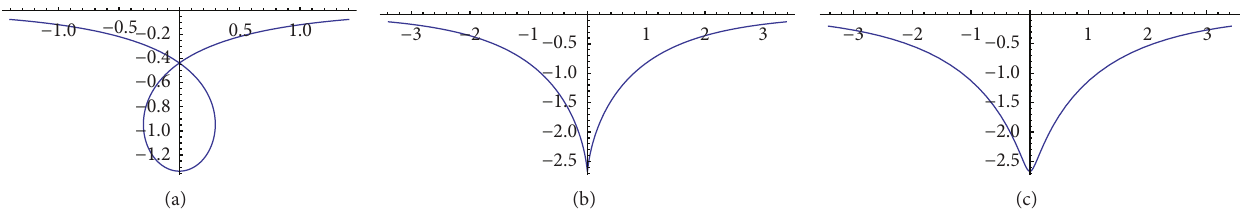
Figure 1: The profile of solution (44) with 𝑝 = 3 , 𝑞 = 1.5 , 𝑡 = 0 , and 𝑥 0 = 0 . For (a) loop-shaped 𝛽 = 0.005 , 𝜇 = −0.5 , (b) cusp-shaped 𝛽 = 0.05 , 𝜇 = −1 , and (c) hump-shaped 𝛽 = 0.5 , 𝜇 = −1